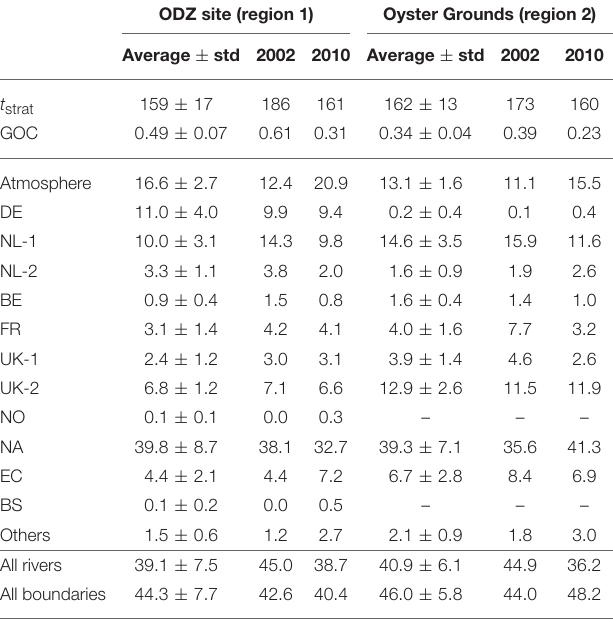
TABLE 3 | Averages and standard deviations (std) during 2000–2014 and values for 2002 and 2010 at ODZ site and at Oyster Grounds (see Figure 5 , regions 1 and 2, respectively): stratification periods [ t strat ; according to Equations (1, 2) in Große et al. (2016)], daily near-bottom GOC and relative contributions of different N